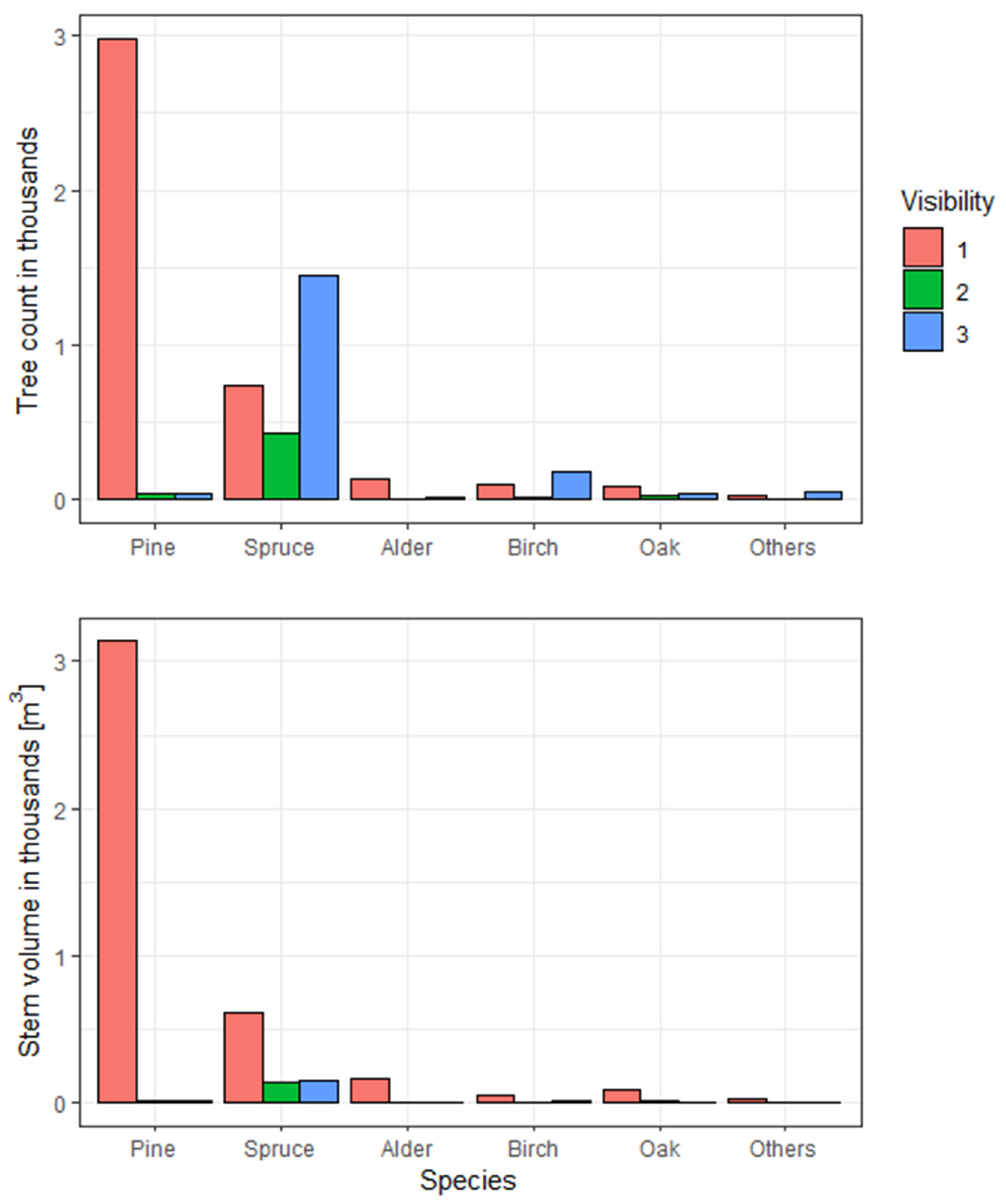
Figure 2. Comparison of field tree count of each species in the analyzed stands distinguishing by their visibility in the context of stem volume.